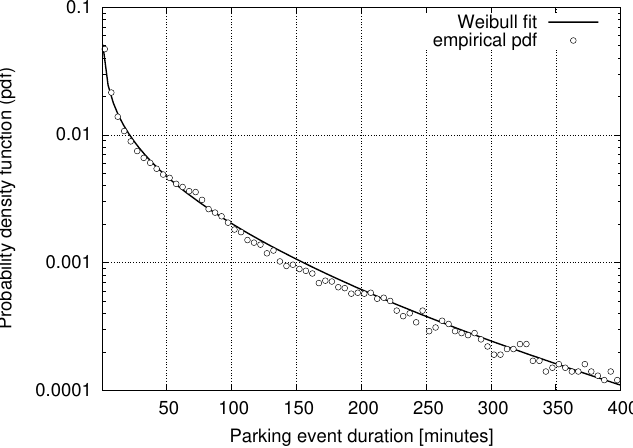
Figure 1. Probability distribution function of the parking duration (random variable (r.v.) t ON